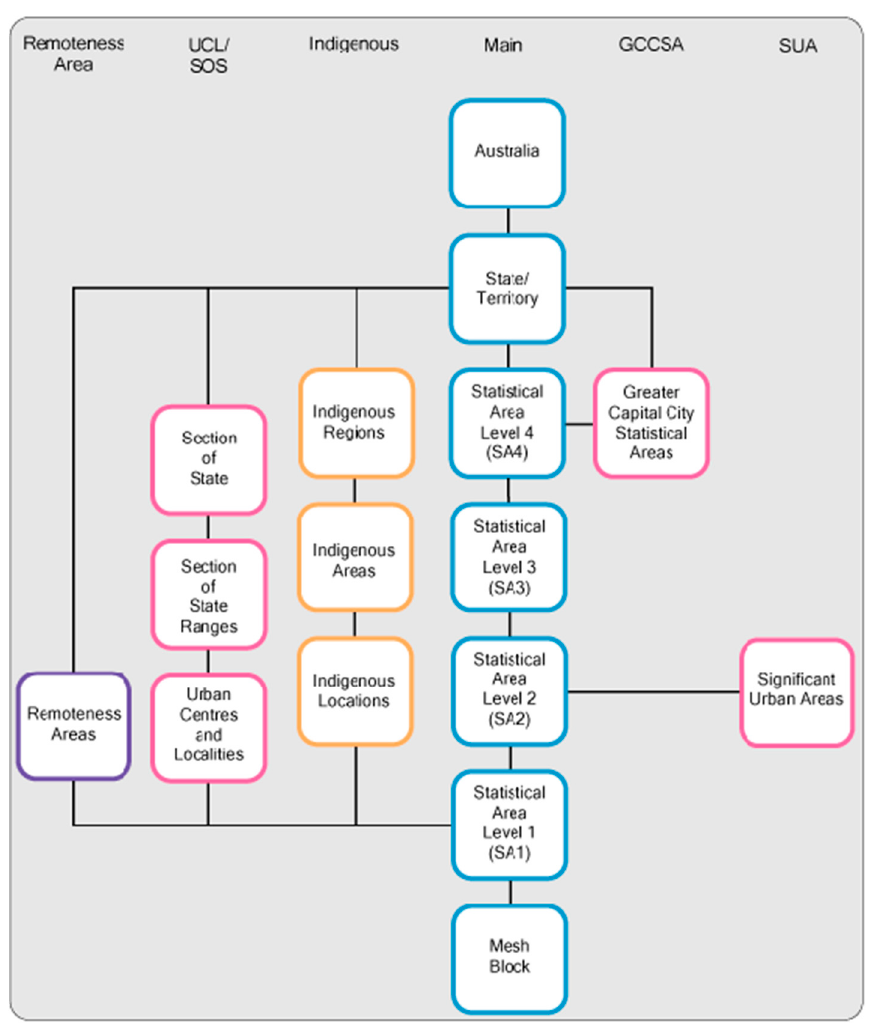
Figure 3. Australian Statistical Geography Standard: Structure (Source: ABS).